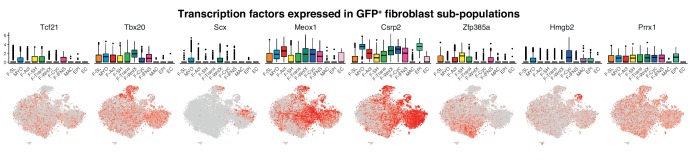
Population-specific expression of transcription factors marking fibroblast and myofibroblast sub-populations.